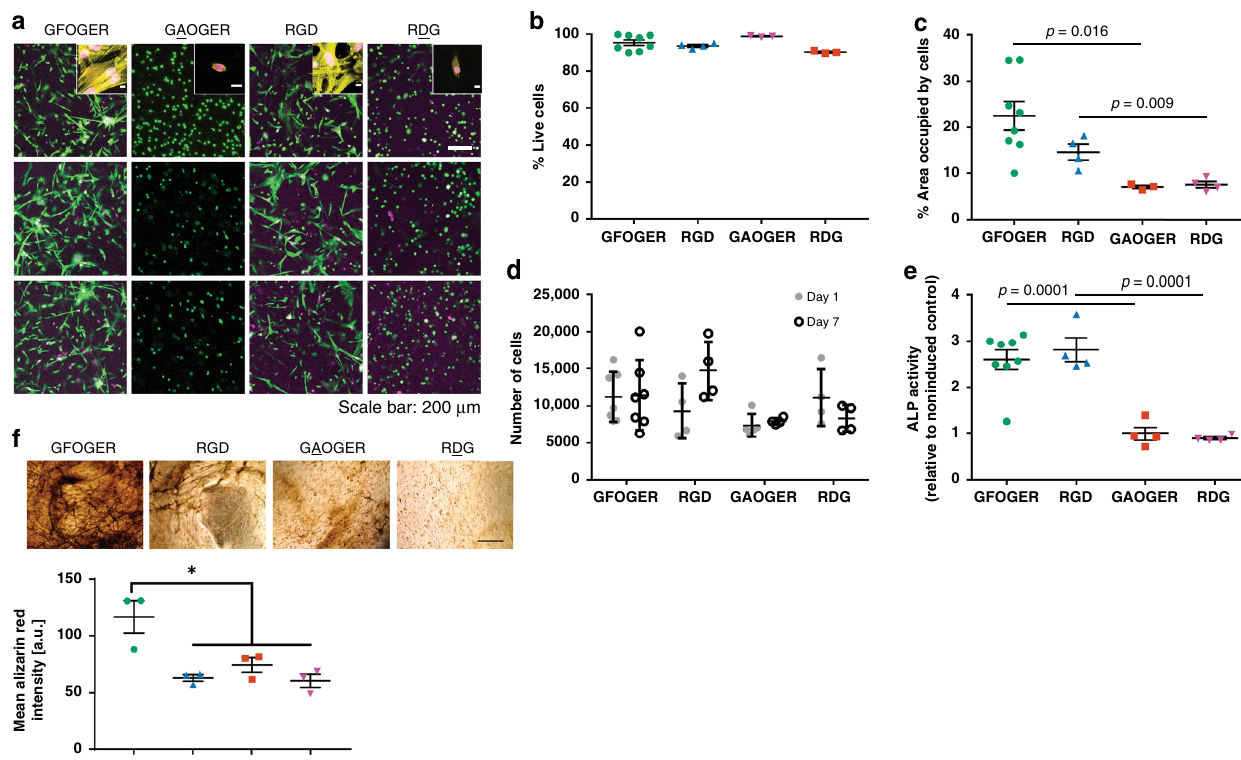
Fig. 2 Integrin-speci fi c peptide-functionalized hydrogels modulate in vitro behaviors of encapsulated hMSC. a Hydrogel-encapsulated hMSCs were cultured for 7 days and stained with Calcein-AM (green) and ethidium homodimer (magenta). Inset shows actin (yellow) and nuclei (magenta) stains. Scale bar 200 µ m, 10 µ m inset. b Quanti fi cation of viability staining indicates high viability (>90%) in all peptide-functionalized hydrogels. Each point represents a biologically independent sample (sample size: GFOGER = 8, RGD = 4, GAOGER = 3, RDG = 3), mean ± SE. c Quanti fi cation of spread cell area indicates signi fi cantly more spreading in GFOGER- and RGD-functionalized hydrogels compared with non-adhesive GAOGER- and RDG-functionalized hydrogels, respectively. Each point represents a biologically independent sample (Sample size: GFOGER = 8, RGD = 4, GAOGER = 3, RDG = 4), mean ± SE. Kruskal – Wallis test ( p < 0.0001) was used to detect differences followed by Dunn ’ s multiple comparisons test, p < 0.016 GFOGER vs. GAOGER; p < 0.009 RGD vs. RDG. d Quanti fi cation of cell number by DNA content for hMSC-laden peptide-functionalized hydrogels cultured over 1 week. Each point represents a biologically independent sample (sample size: GFOGER = 7, RGD = 4, GAOGER = 5, RDG = 4), mean ± SD. Two-way ANOVA did not show differences ( p = 0.44). e Alkaline phosphatase activity was quanti fi ed for hMSC encapsulated in peptide-functionalized hydrogels and cultured for 9 days in growth or osteogenic conditions. Each point represents a biologically independent replicate (sample size: GFOGER = 8, RGD = 4, GAOGER = 4, RDG = 4), mean ± SE. ANOVA ( p < 0.0001) was used to detect statistical differences followed by Sidak ’ s multiple comparisons test with adjustment for multiple comparisons, p < 0.0001 GFOGER vs. GAOGER; p < 0.0001 RGD vs. RDG. f Alizarin red staining of mineral deposition by hMSC encapsulated in integrin-speci fi c hydrogels after 14 days of culture in growth media. Representative images of Alizarin red stained hMSC-laden hydrogels (scale bar 100 µ m) and quanti fi cation of the mean Alizarin red intensity in the images. n = 3 independent samples per group, mean ± SE; * p < 0.05. ANOVA ( p < 0.0053) was used to detect statistical differences followed by Tukey ’ s multiple comparisons